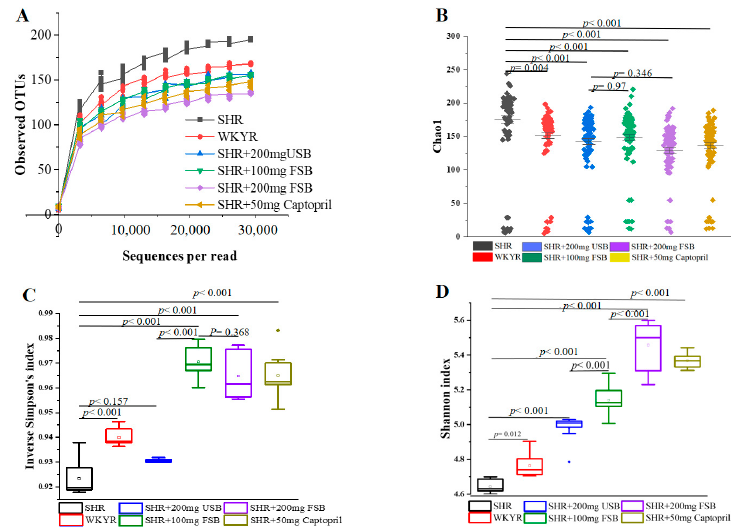
Figure 3. Gut microbial alpha diversity varies with FSB and USB feeding in SHR. ( A ). Rarefaction curve. ( B ). Chao-1 index. ( C ). Inverse Simpson’s index. ( D ). Shannon index as observed in SHR after feeding with FSB or USB for 4 weeks compared with WKYR and untreated SHR.